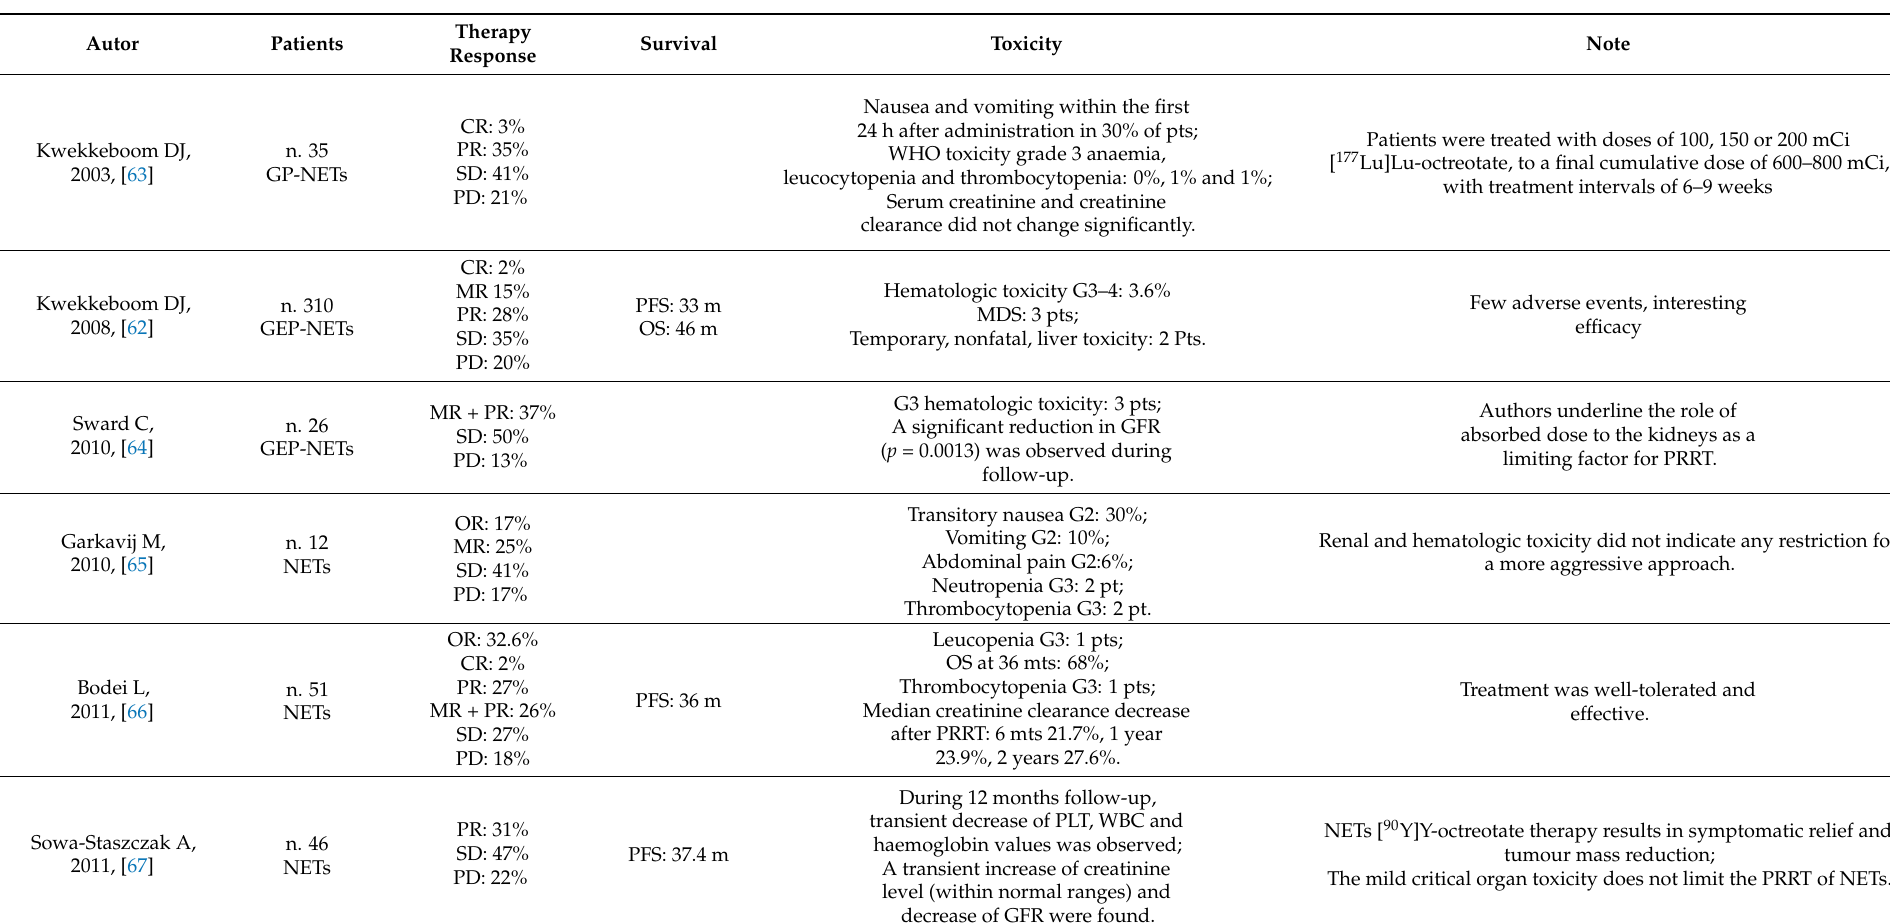
Table 4. The main studies in which the radiopeptide [ 177 Lu]Lu-DOTATATE was used for the treatment of neuroendocrine tumors (NETs), gastro-entero-pancreatic tract (GEP-NETs) and other